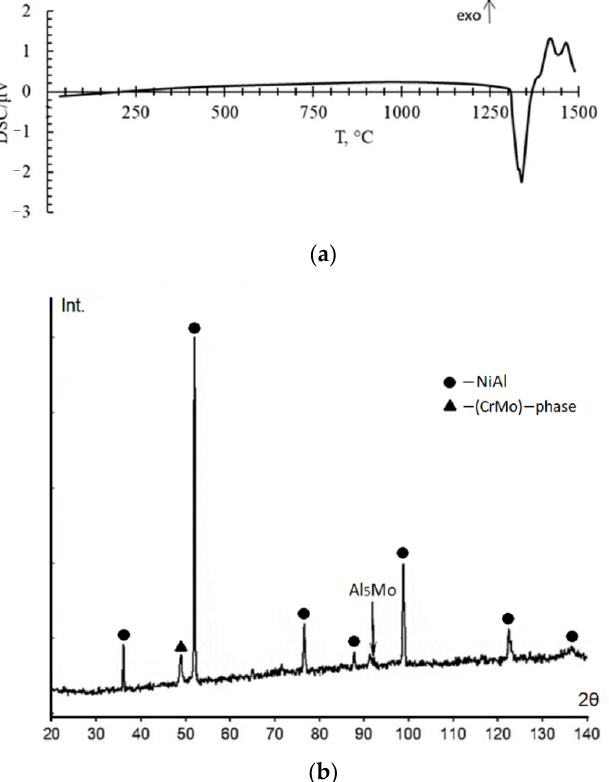
Figure 3. Results of DSC analysis of the matrix powders ( a ) and XRD spectrum of matrix samples after DSC ( b ).